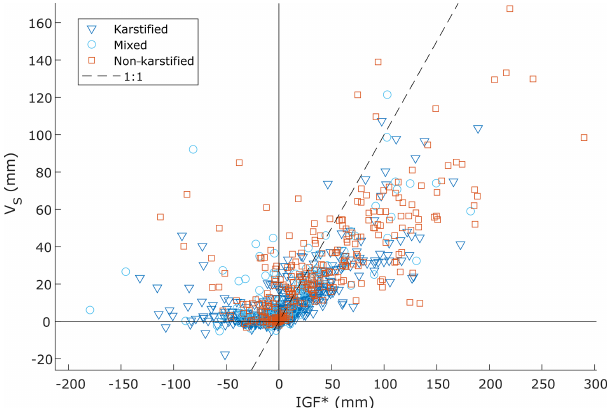
Figure 11. V S depths versus IGF ∗ depths for all events and reaches, with differentiation of geology